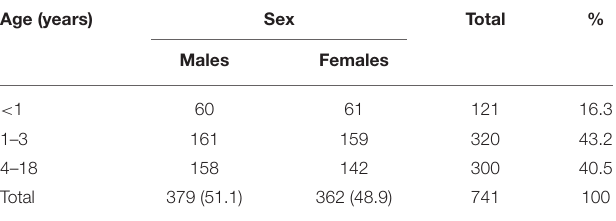
TABLE 2 | Age and sex distribution of 741 patients with UTI.